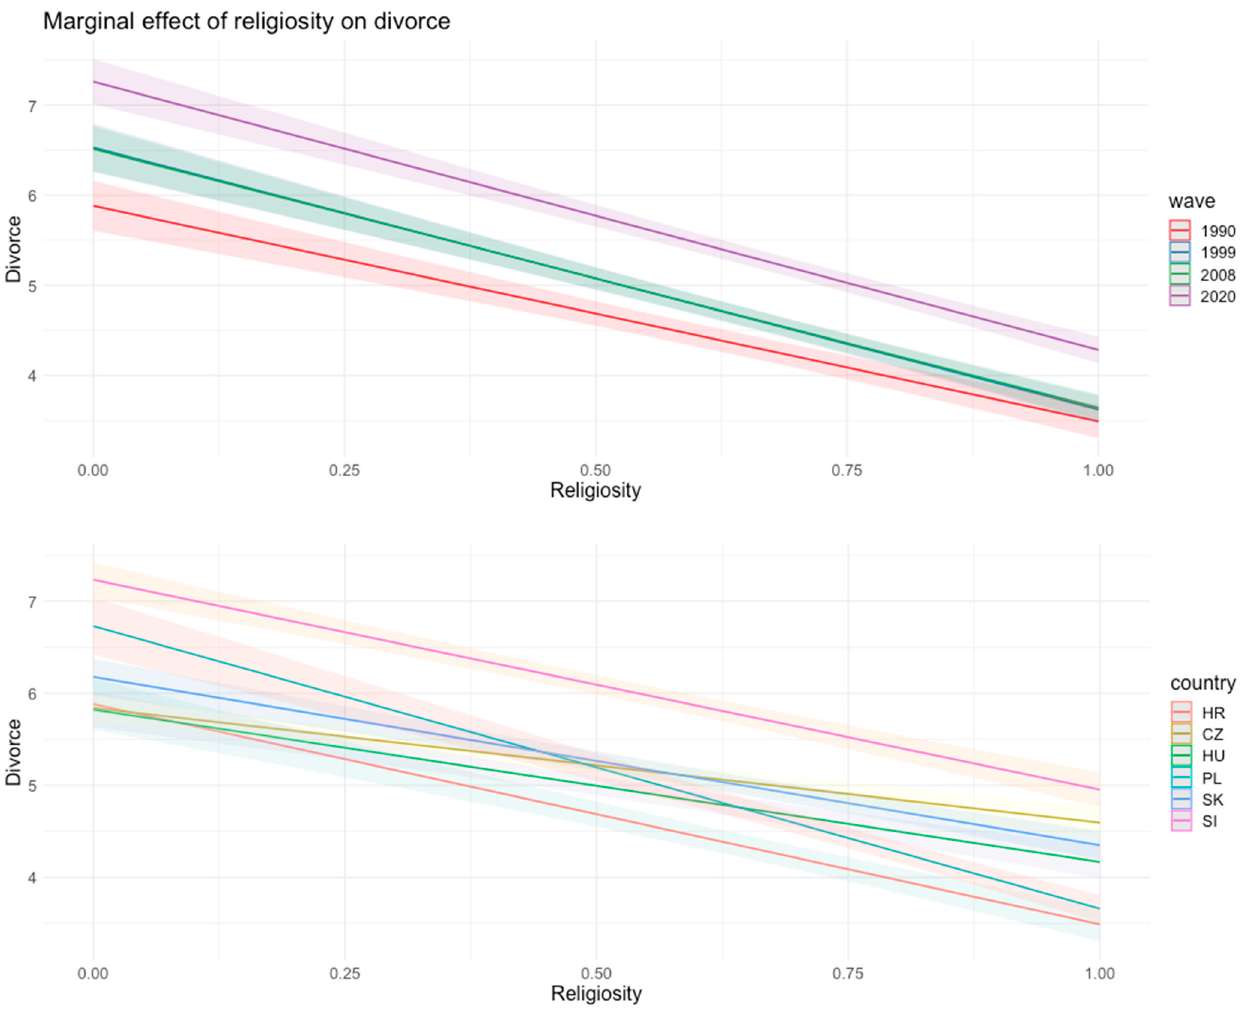
Figure 4. Predicted marginal means of divorce per waves and countries on different level of religiosity. A more detailed regression table with the interaction effects is available in the Supplementary Materials.